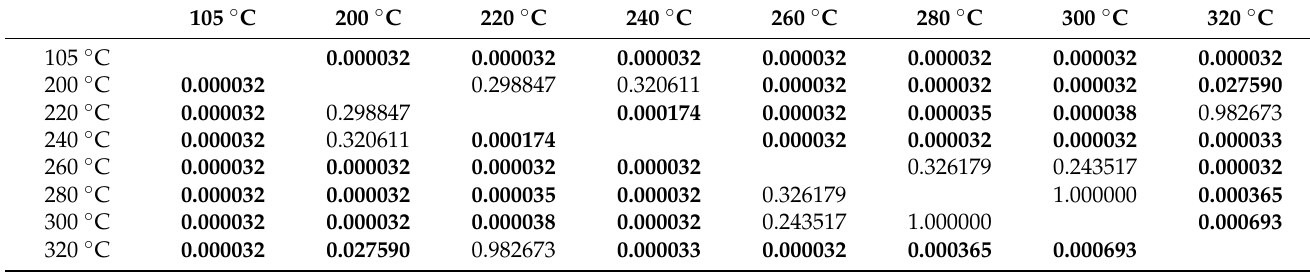
Table A3. Significant differences for the EMC variable for the effect of torrefaction temperature (TT) according to Tukey’s test (HSD) for mandarin peels.